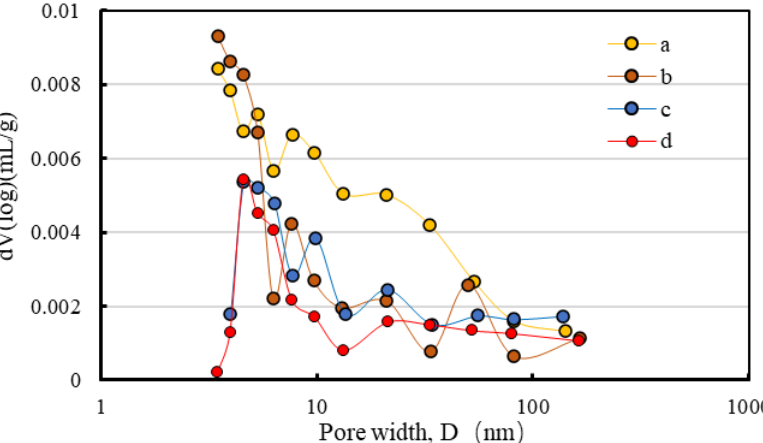
Figure 14. The typical nonmicrocrope size distributions (PSDs) of shales for these 4 members of S 1 l 1 − 1 . a. 2393.55 m, N3, S 1 l 1 − 1a ; b. 2385.15 m, N3, S 1 l 1 − 1b ; c. 2380.11 m, N3, S 1 l 1 − 1c ; d. 2371.35 m, N3, S 1 l 1 − 1d